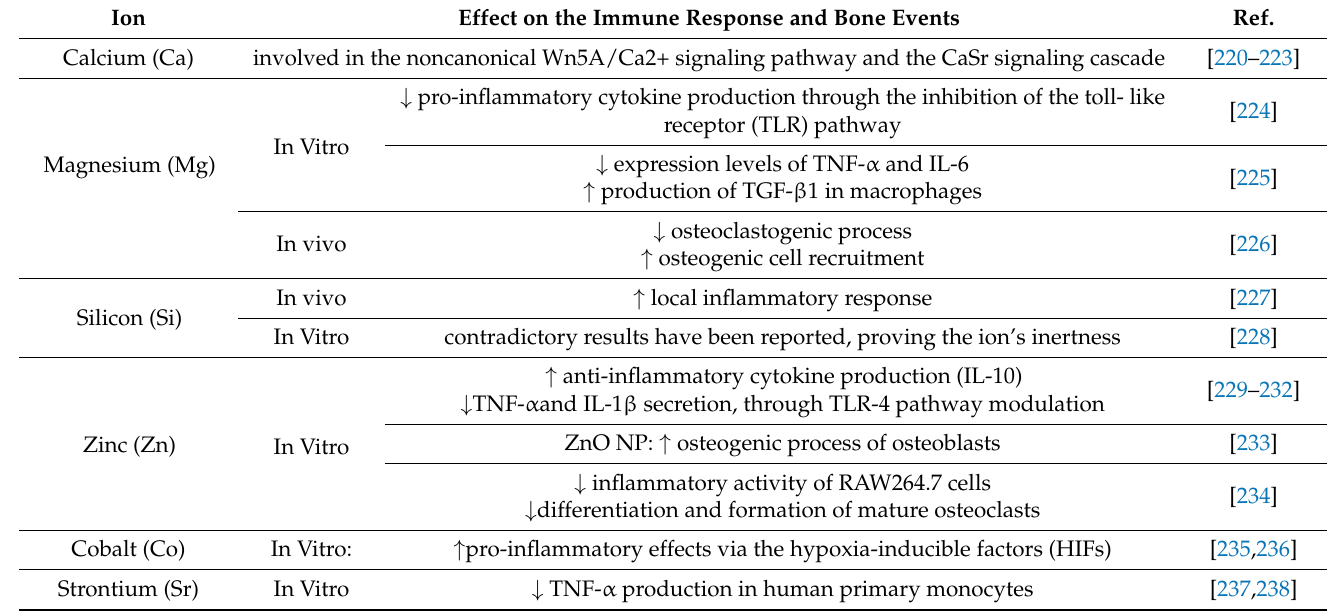
Table 2. The effects of various ions on the immune response and bone-related events. Ion Effect on the Immune Response and Bone Events Ref. Calcium (Ca) involved in the noncanonical Wn5A/Ca2+ signaling pathway and the CaSr signaling